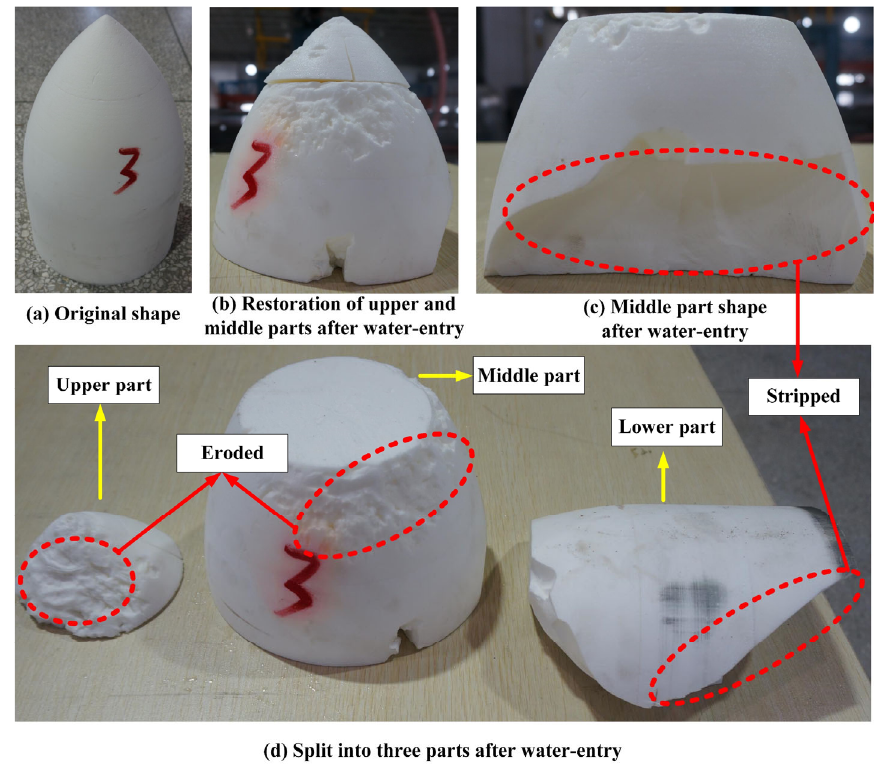
Figure 16. Comparison of No. 3 head cap before and after water entry.